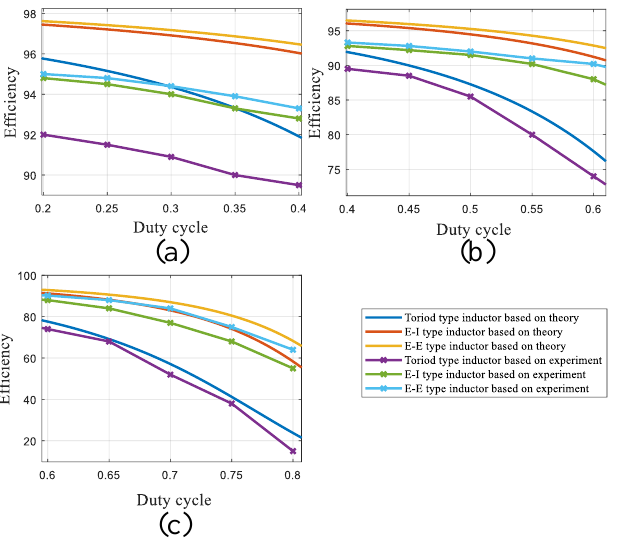
Figure 20. The efficiency comparison based on the theory and experimental results of the toroid type, E–E type, and E–I type of the inductor cores as the duty cycle changes from ( a ) 0 to 33%, ( b ) 33% to 66%, and ( c ) 66% to